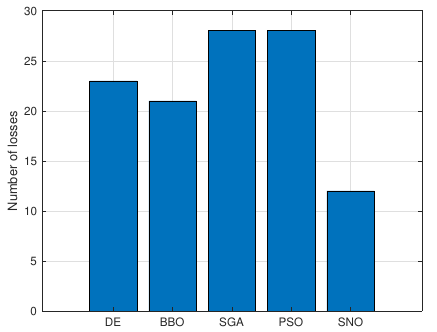
Figure 7. Number of losses in the comparison between the average final value obtained by DE, BBO, SGA, PSO, and